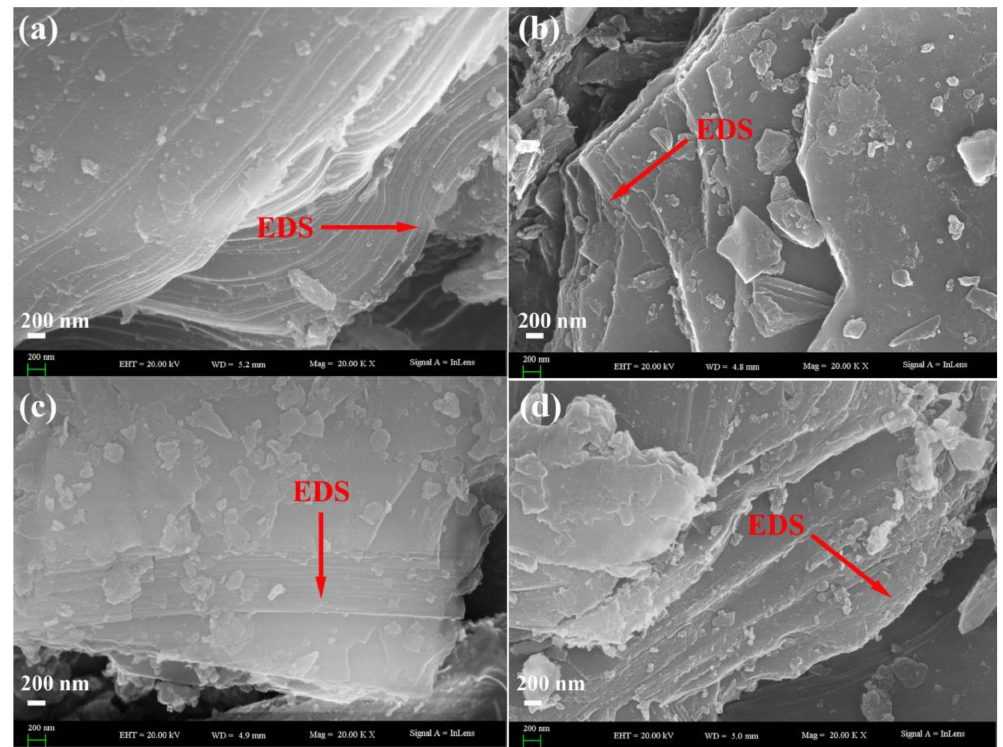
Figure 5. Scanning electron microscopy (SEM) images of ( a ) a-Verm; ( b ) OVerm; ( c ) PAM/OVerm; ( d ) g-PAM/OVerm.